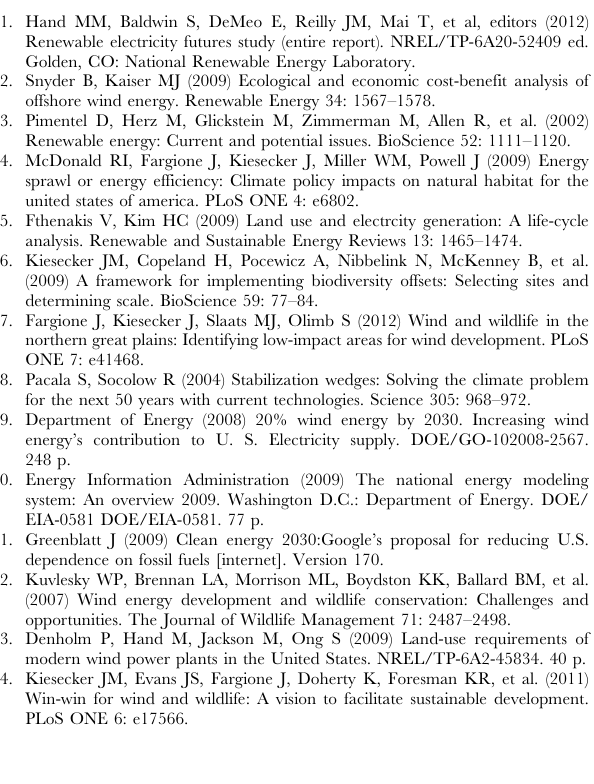
Table S1 Model results for land transformation at the string scale. Sum of variable AICc weights are: Land cover = 0.99, Topography = 0.46, Turbine size = 0.17, Configuration = 0.01. Table S2 Model results for land transformation at the site scale. Sum of AICc weights are: Land cover = 0.99,